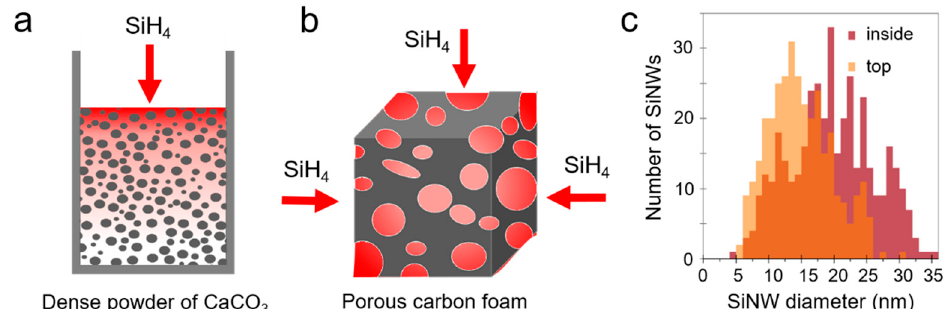
Figure 2. Scheme of the partial pressure reduction in the porous growth support, CaCO 3 powder ( a ) and carbon foam cube ( b ). The SiH 4 pressure is represented in red shades. ( c ) Diameters of Si nanowires (SiNWs) grown from 1–2 nm gold nanoparticles (AuNPs) in a 1 cm 3 carbon foam cube on the surface (“top”) and 2 mm below the surface (“inside”). Inside, SiNWs had the same diameter distribution at all depths down to the center.